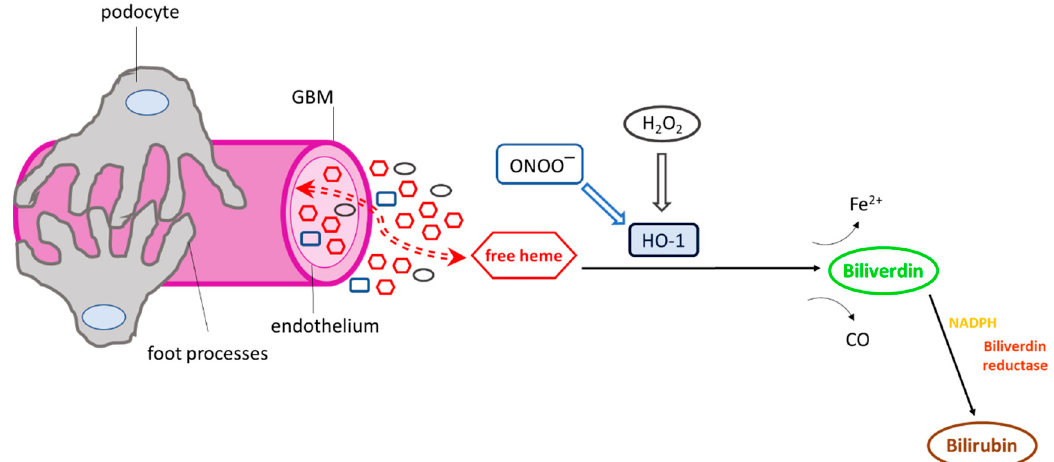
Figure 2. Exposure of the glomerular microvasculature to various heme oxygenase-1 (HO-1) inducers. Numerous HO-1 inducers, including heme, hydrogen peroxide (H 2 O 2 ), and peroxynitrite (ONOO − ), are present in the glomerular milieu under conditions of glomerular injury, which may activate HO-1. Once activated, the cytoprotective enzyme degrades heme and releases Fe 2+ and carbon monoxide (CO). Biliverdin is then converted to bilirubin in the presence of biliverdin reductase and NADPH. The HO-1 reaction products (CO, biliverdin, bilirubin) have well-known antioxidant and antiapoptotic properties and potentially mediate the activation or inhibition of various cellular pathways or may act as